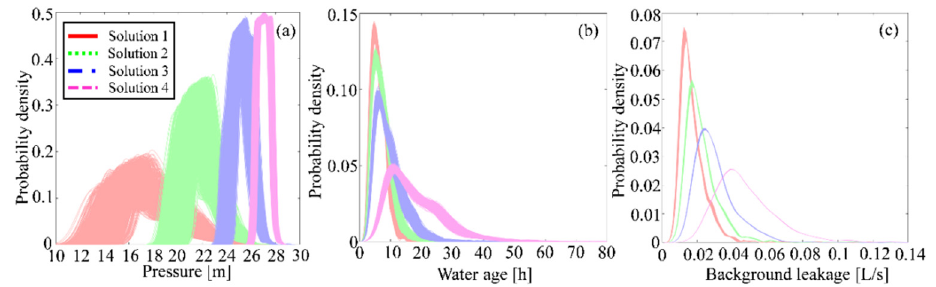
Figure 9. Probability density distributions of the three key indicators for the four solutions under 50,000 demand loading cases: ( a ) nodal pressure, ( b ) water age and ( c ) background leakage.